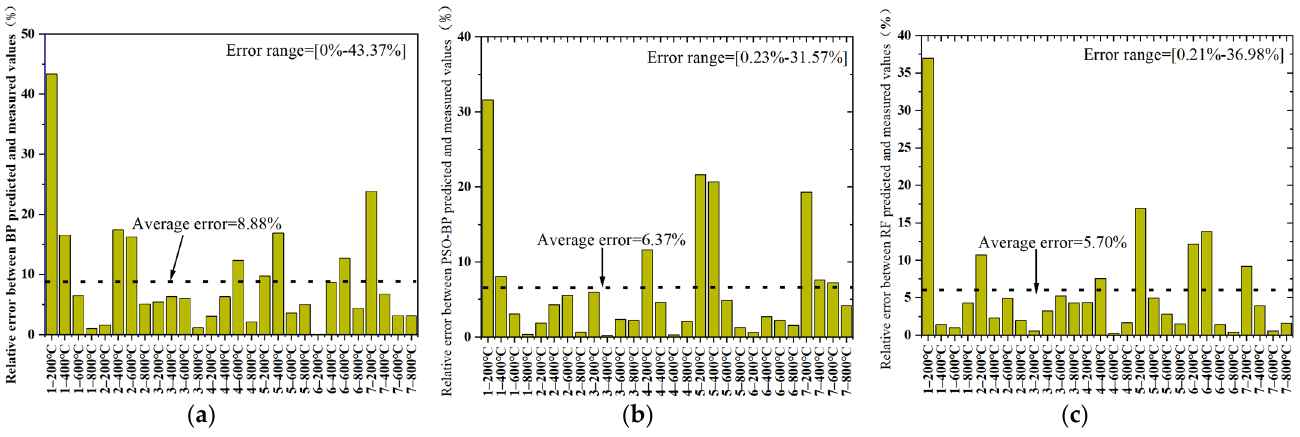
Figure 11. Error between the values predicted and measured. ( a ) BP model. ( b ) PSO-BP model. ( c ) RF model. Table 7. Statistic of the error between the results measured and predicted. Table 6. Compressive strength loss percentages measured and predicted.